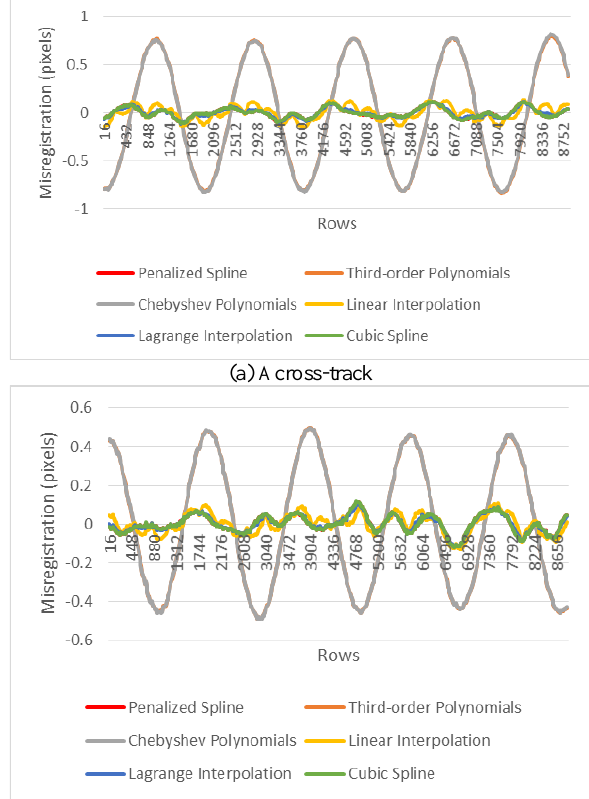
Figure 8 Band-to-band misregistration of the Dengfeng dataset caused by the attitude errors.